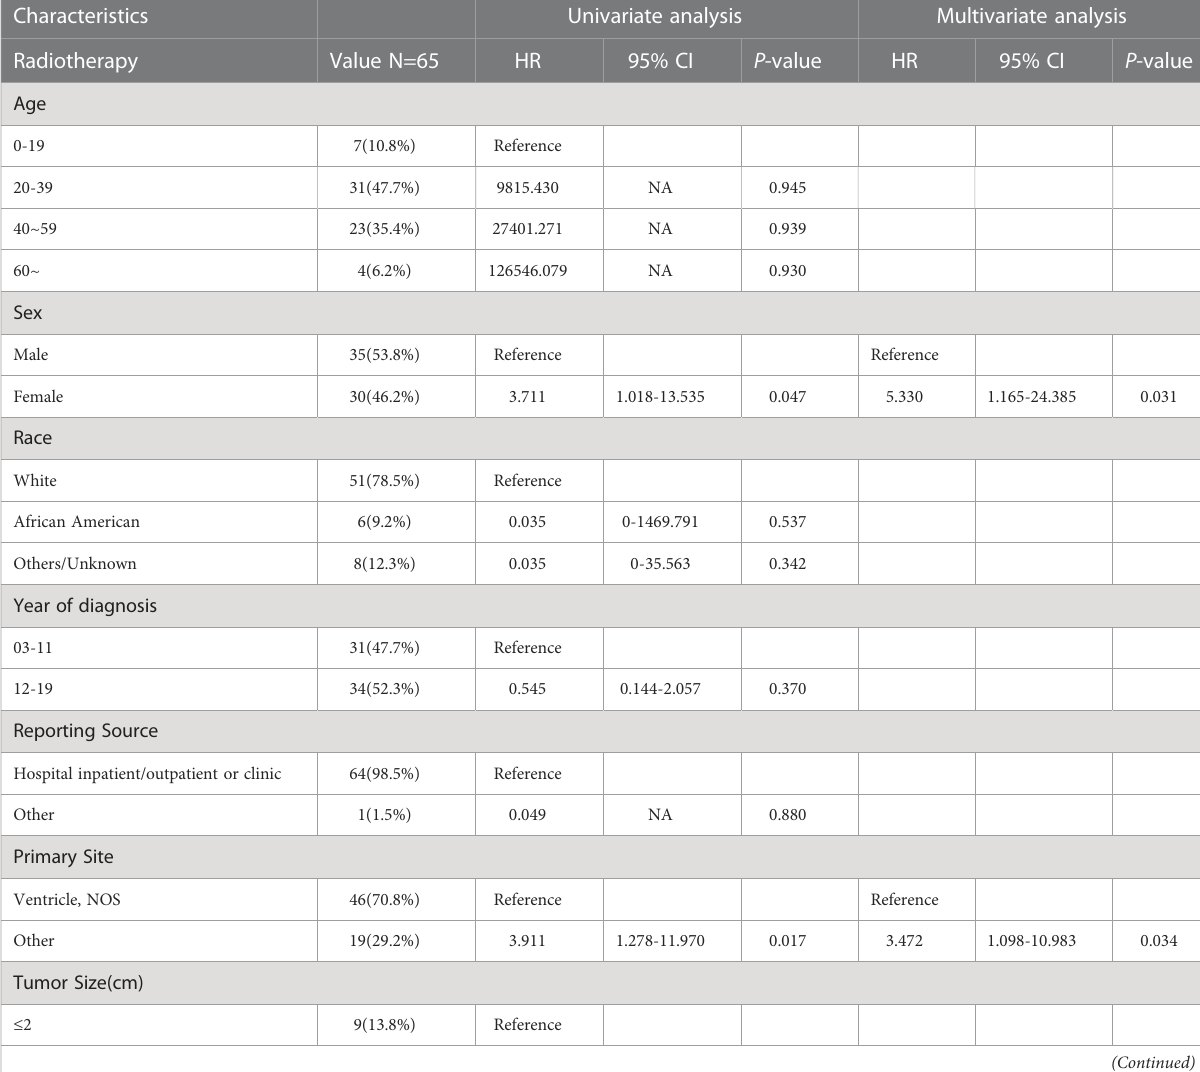
TABLE 5 The median overall survival (OS) of the radiotherapy subgroup was 67 (interquartile range (IQR): 30 – 115) months.